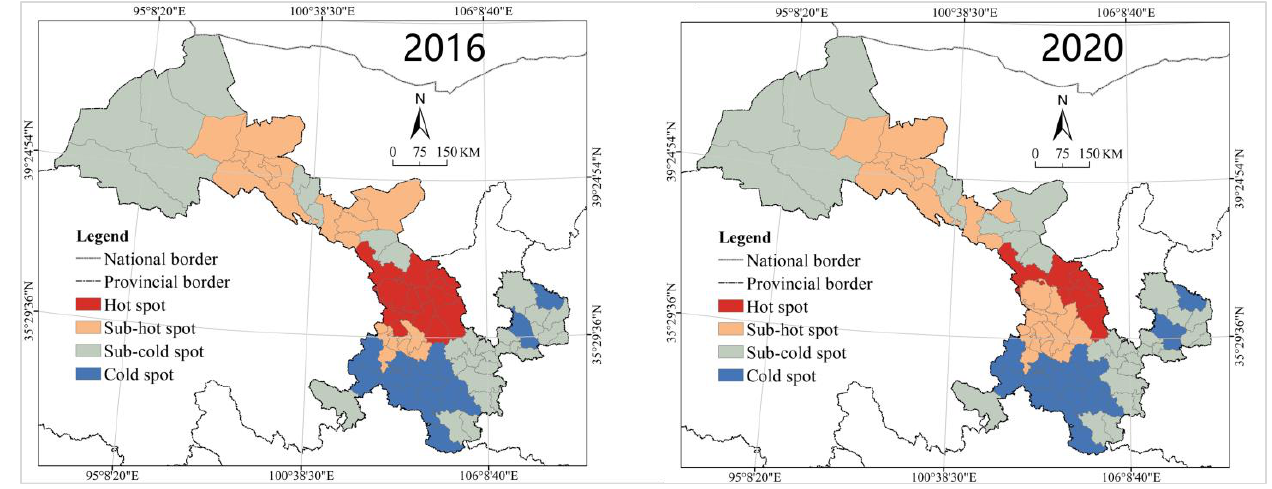
Figure 6. Analysis on the spatial cold and hot spot of urban construction land scale in Gansu.